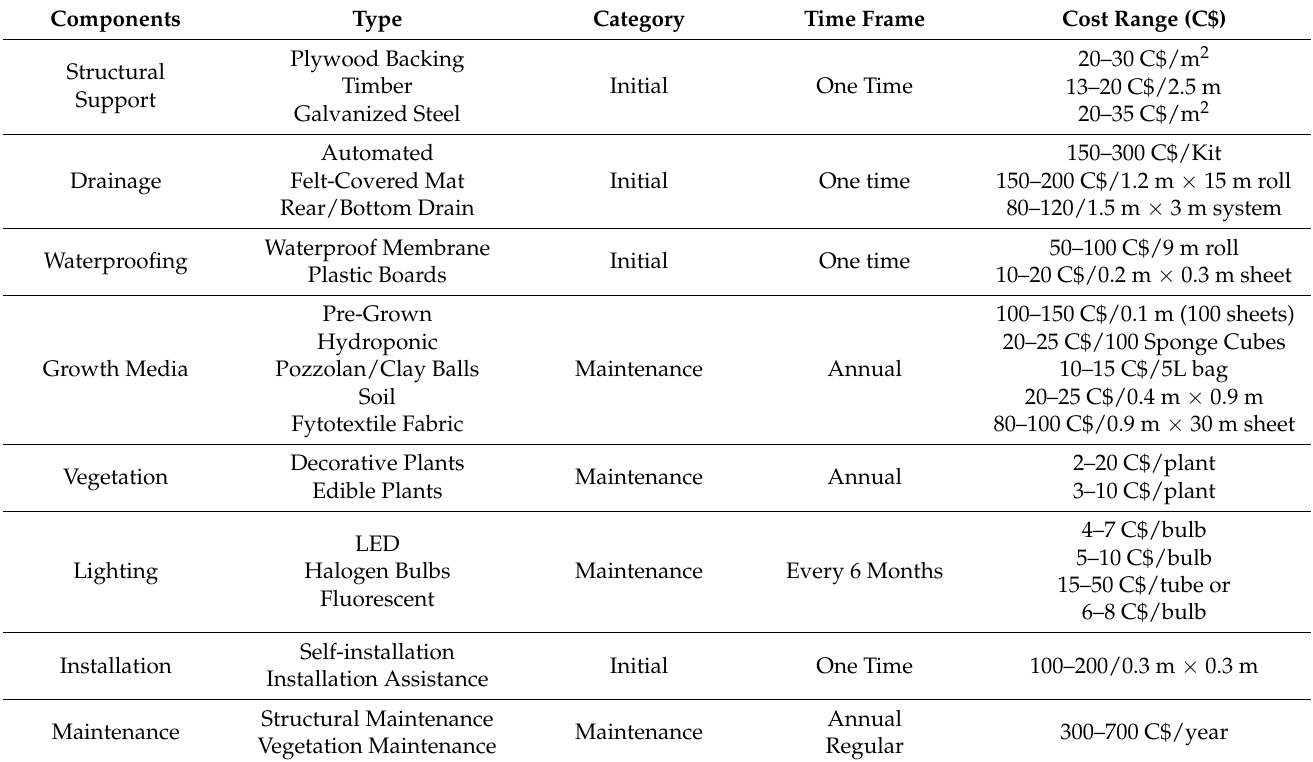
Table 1. Costs related to living wall systems. Note: The choice of components depends on the size and the design of the living wall, where some of them can be